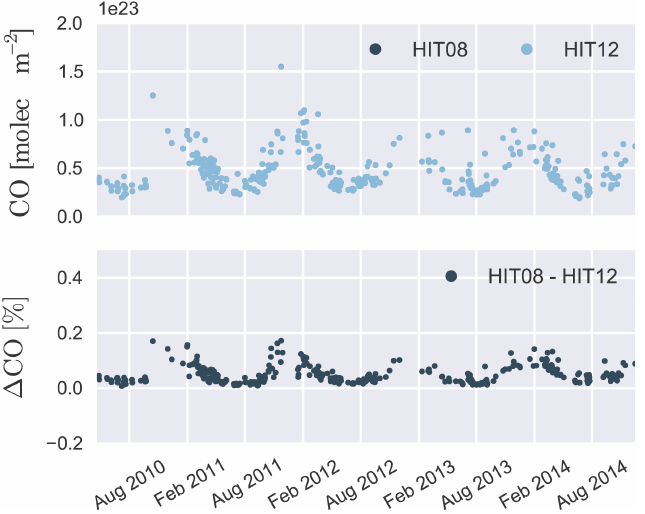
Figure A3. Upper panel: daily mean time series of CO slant columns retrieved from MIR spectra for HITRAN 2008 (HIT08) and HITRAN 2012 (HIT12); the lower panel shows the relative difference time series. The maxima in both time series are in phase.